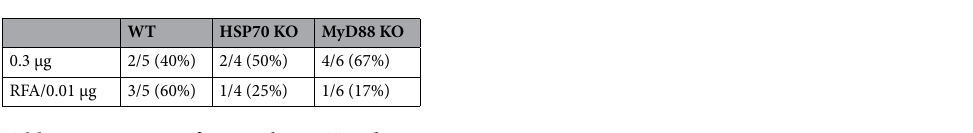
Table 1. Summary of survival in WT and KO